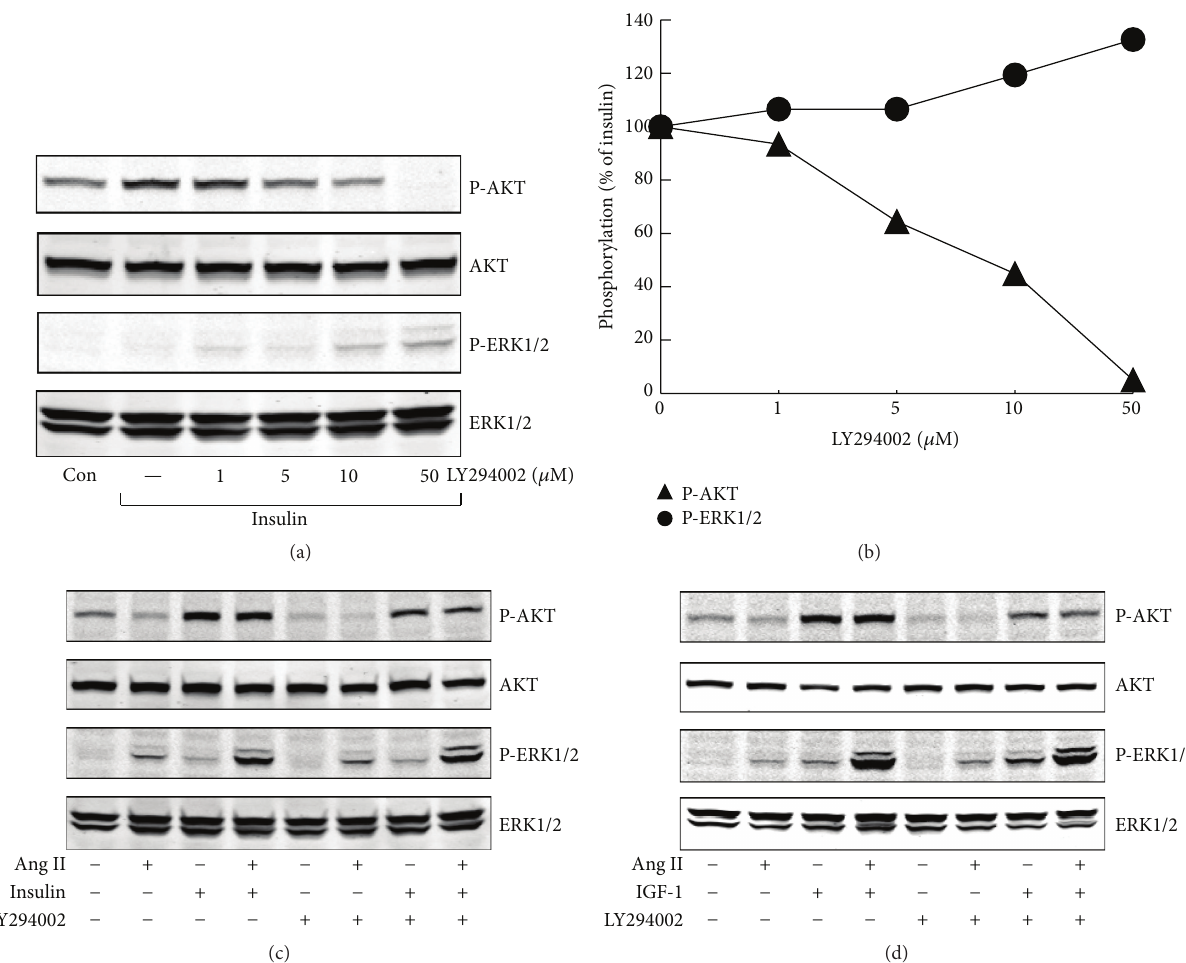
Figure 6: Involvement of PI3K in agonists-stimulated phospho-ERK1/2 and phospho-AKT in H295R cells. (a) Effects of LY294002, a PI3K inhibitor, on insulin-induced ERK1/2 and AKT phosphorylation. H295R cells were treated with increasing concentrations of LY294002 for 30 min and then stimulated with insulin (100nM) for 5min. (b) Quantitative determination of the effects of LY294002 on insulin-induced ERK1/2 and AKT phosphorylation from panels (a). (c and d) After incubation with LY294002 (5 𝜇 M) for 30 min, H295R cells were pretreated with Ang II (100nM) for another 30 min and then stimulated with insulin/IGF-1 for 5 min. (c) Insulin (100nM); (d) IGF-1 (10nM). CYP11B1 mRNA